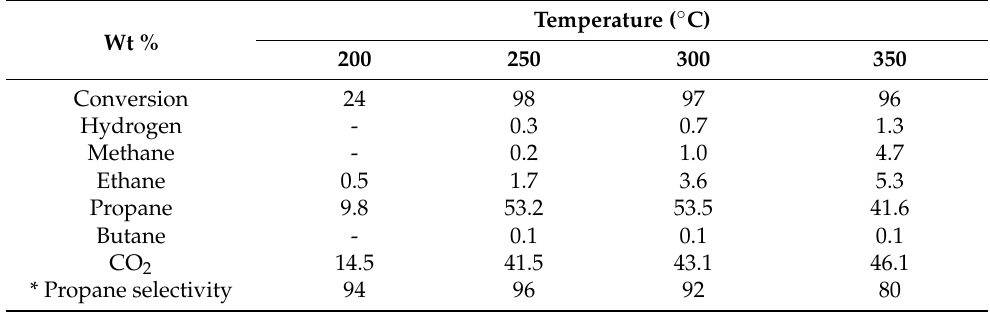
Table 1. Butyric acid conversion and product yields under nitrogen atmosphere at different temperatures. Wt